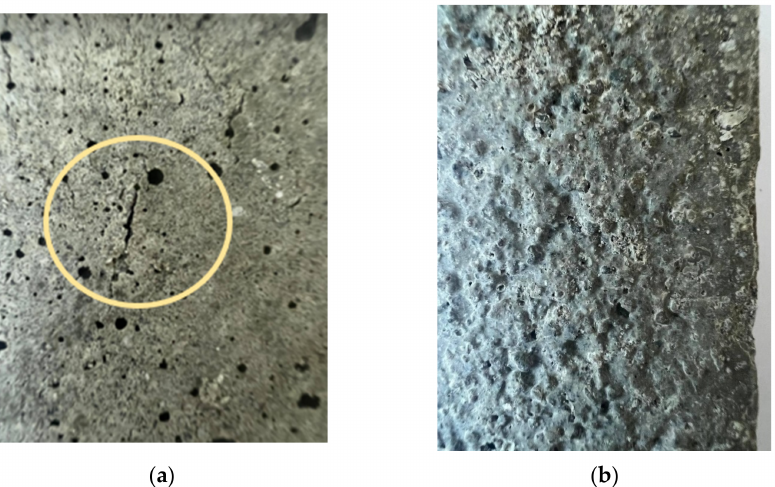
Figure 6. Damaged structure of geopolymer mix with the addition of MSWIBA: ( a ) swelling and crack surface; ( b ) bubbled